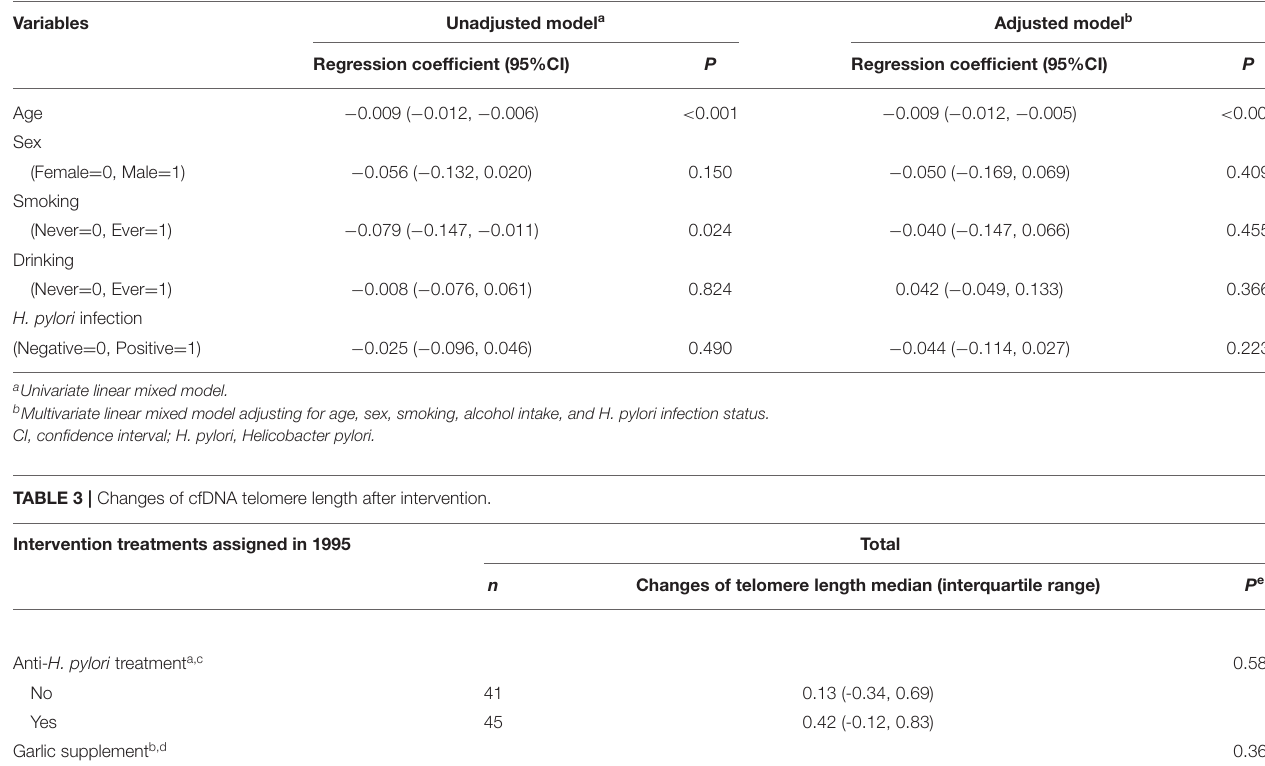
TABLE 2 | Relationships between epidemiologic parameters and telomere length of cfDNA from baseline and follow-up time-points.